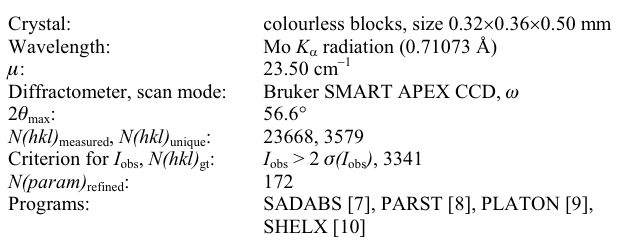
Table 1. Data collection and handling.